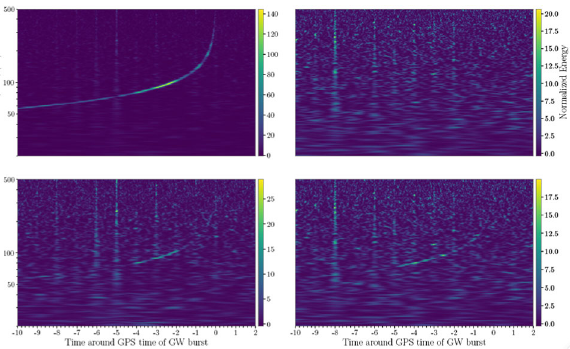
Fig. 2 Time-frequency representations of left-hand (left panels) and right-hand (right panels) polarization signals reconstructed from the simulated GW data of signal + noise for the second-generation detector network. Upper panels show the results of a face-on GW event, and the lower panels show those of an edge-on